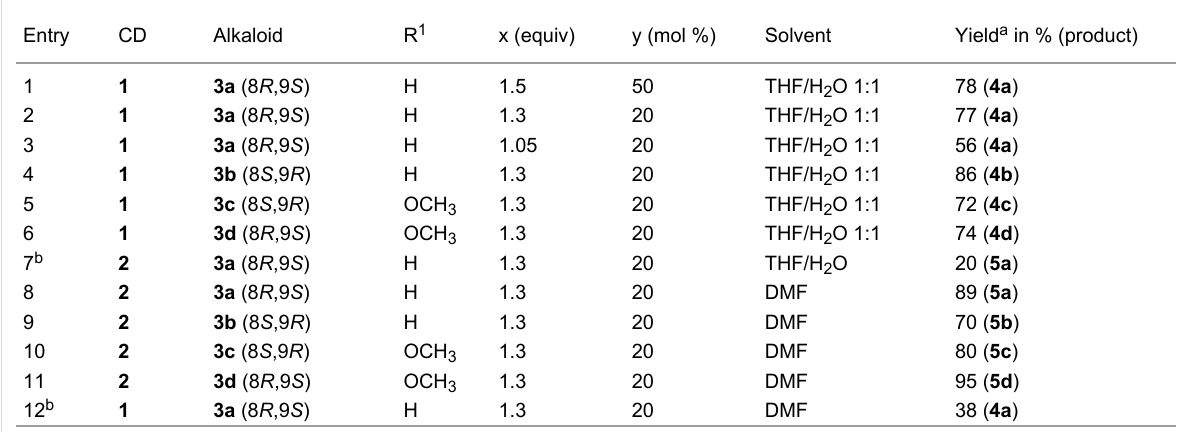
Table 1: Optimized conditions of the CuAAC click reactions of non-methylated azido-CDs with propargylated cinchona alkaloids depicted in Scheme 1.